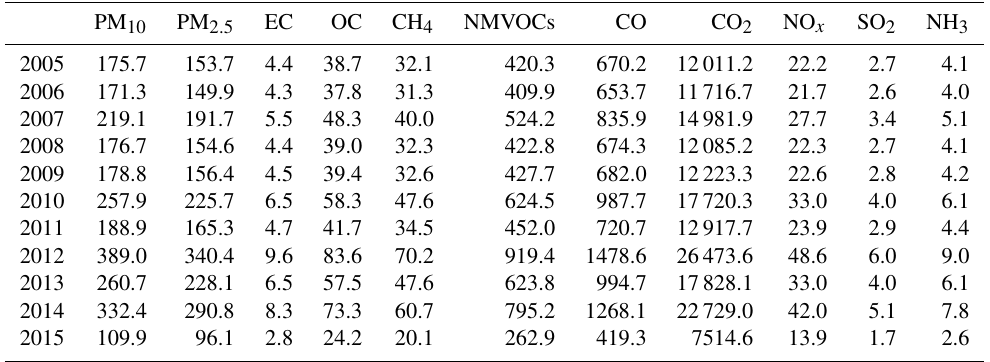
Table 1. Constrained OBB emissions from 2005 to 2015 in the YRD (unit: Gg); OC: organic carbon; EC: elemental carbon. PM 10 PM 2 . 5 EC OC CH